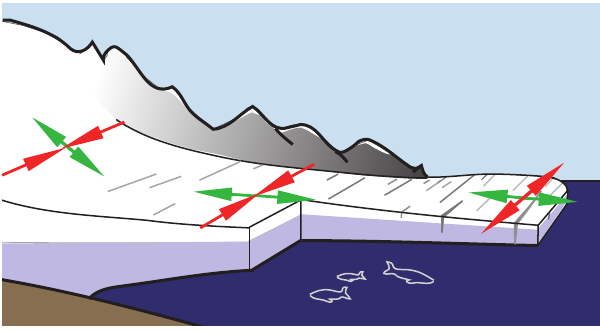
Fig. 4: Schematic diagram of calving law (see Eq. 30). Green arrows denote the eigen-direction along the flow direction, red arrows the eigen-direction perpendicular to the flow direction. Con- vergence of ice flow perpendicular to the main flow direction is associated with closure of crevasses whereas spreading in both directions (corresponding to positive eigen-values ˙ (cid:15) ± ) is associated with intersecting crevasses and enhanced calving.